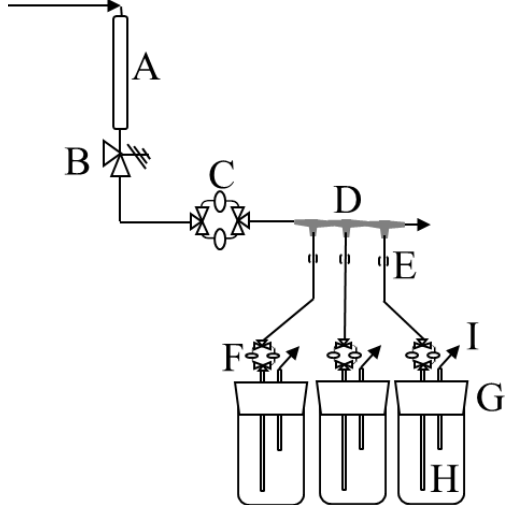
Figure 1. Desiccation system, comprising: A – hydrocarbon trap. B – pressure release valve. C – flow control system; system comprises two three-way valves and two needle valves allowing either a high or low flow to be selected. D – Luer taps to turn flow on/off to indi- vidual flasks. E – mini hose clamp to control flow through Tygon ® tubing to each flask. F – (smaller) flow control system 2, see C. G – rubber bung and glass inlet and outlet tubes (arranged at differ- ent heights to ensure air circulation through the whole flask). H – 1L wide-necked glass Duran ® incubation vessel (seaweed sample placed on bottom of flask). I – 1 / 4 inch Ultra-torr fitting outflow, sorbent tubes or flowmeter connected